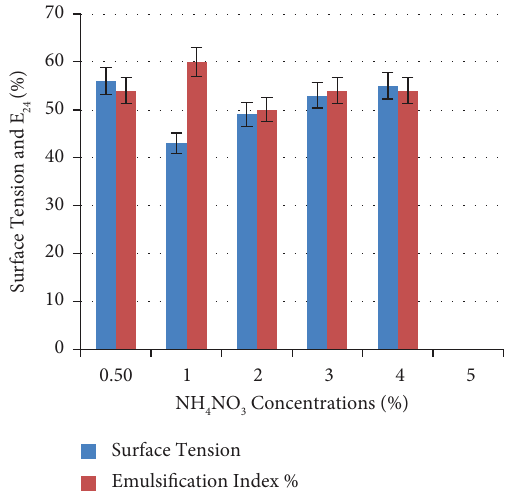
Figure 10: Efect of NH 4 NO 3 concentrations on biosurfactant production. A maximum E 24 % (60 ± 0.33%) and minimum surface tension (49 mN/m) were obtained when NH4NO3 was added in a concentration of 1%